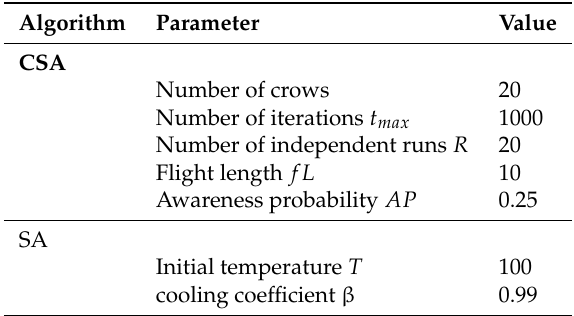
Table 4. Parameter settings of the proposed